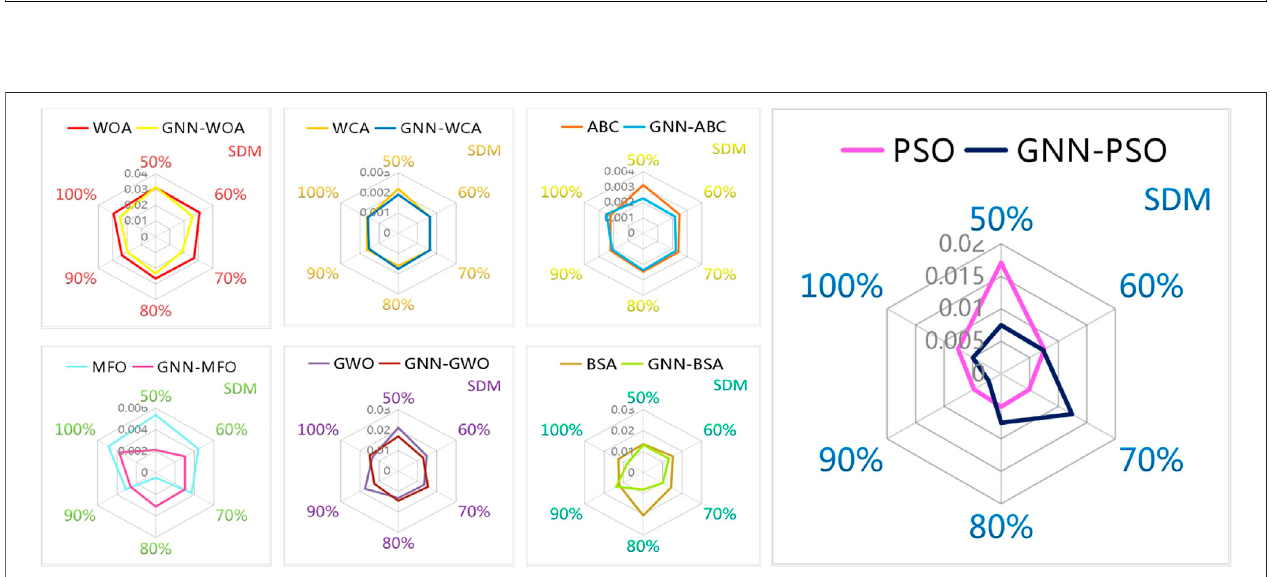
Figure 11 depicts the output curves of the best data prediction-based meta-heuristic algorithm (GNN-WCA) and actual data under 50% and 100% training data,